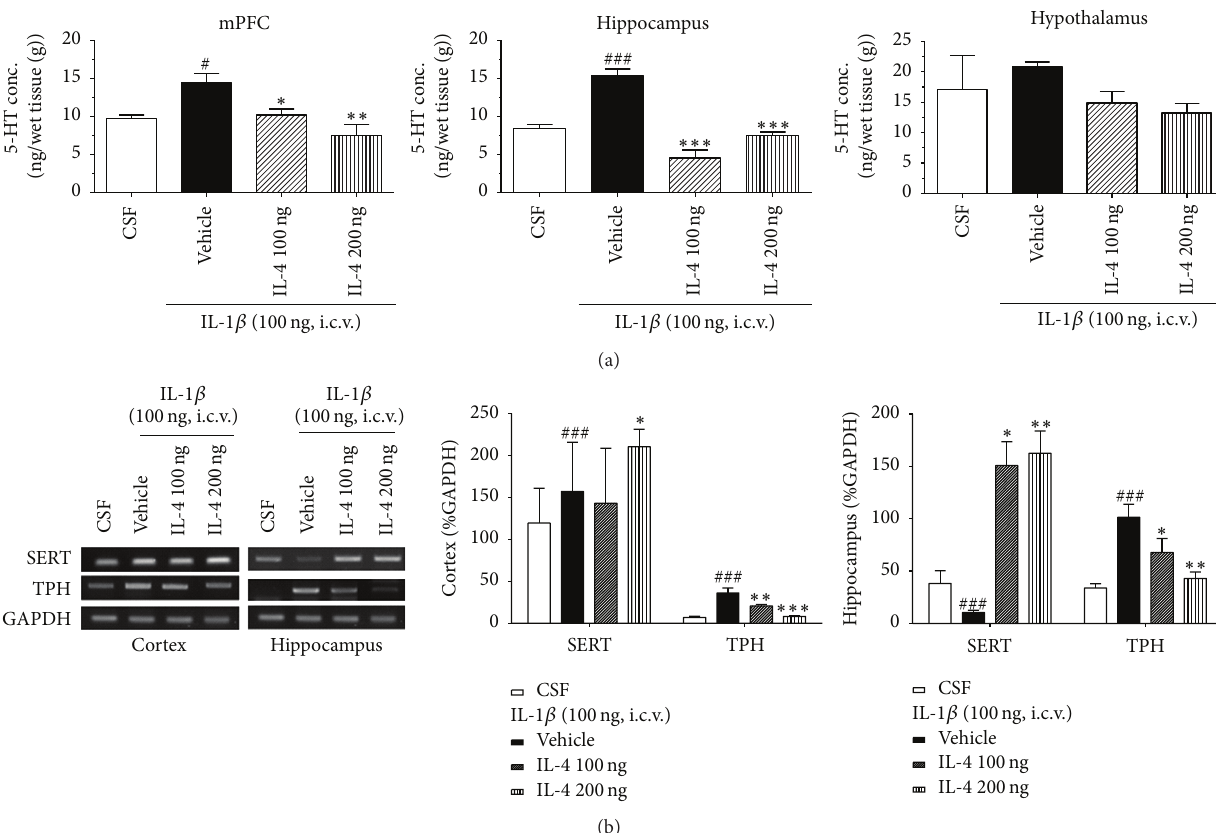
Figure 3: (a) Effect of IL-4 injection 2 hours after injection of i.c.v. IL-1 𝛽 on 5-HT concentration. Mean ( ± SEM) concentrations (nanogram per gram) of 5-HT within the mPFC, hippocampus, and hypothalamus among rats. Each value represents the mean ± SEM. # 𝑃 < 0.05 , ### 𝑃 < 0.001 compared to the CSF and ∗ 𝑃 < 0.05 , ∗∗ 𝑃 < 0.01 , and ∗∗∗ 𝑃 < 0.001 compared to the IL-1 𝛽 treated group. Control, 𝑛 = 5 ; IL-1 𝛽 , 𝑛 = 5 ; IL-4 100ng, 𝑛 = 5 ; IL-4 200ng, 𝑛 = 5 . (b) Effect of IL-4 injection 2 hours after injection of i.c.v. IL-1 𝛽 on SERT and TPH mRNA levels in the brain. Values are means ± SEM. Relative % GAPDH of SERT and TPH mRNA levels within the mPFC and hippocampus among rats. Each value represents the mean ± SEM. ### 𝑃 < 0.001 compared to the CSF, ∗ 𝑃 < 0.05 , ∗∗ 𝑃 < 0.01 , and ∗∗∗ 𝑃 < 0.001 compared to the IL-1 𝛽 treated group. Control, 𝑛 = 5 ; IL-1 𝛽 , 𝑛 = 5 ; IL-4 100ng, 𝑛 = 5 ; IL-4 200 ng, 𝑛 = 5